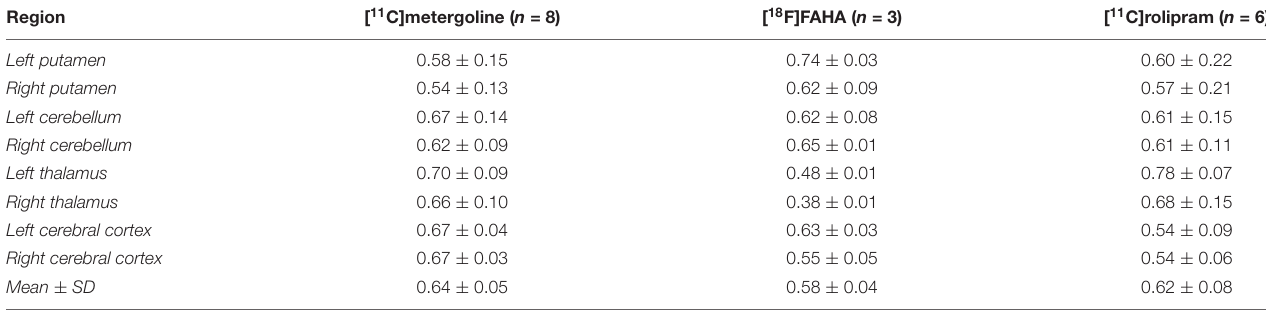
TABLE 3 | Atlas evaluation on positron emission tomography (PET) images by dice similarity coefficient between the atlas and manual segmentation. Region